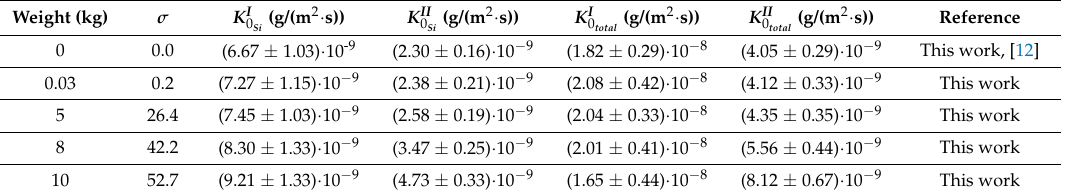
Table 3. The glass dissolution rate constants obtained via the regression of the experimental data using the Dissolving Cylinder Zero-Order Kinetic (DCZOK) model for Si and the total mass loss at 60 ◦ C and at a pH of 5.65 at various stress levels. σ stands for stress; K I rate constants for Phase I and II for Si and total glass dissolution, as indicated by